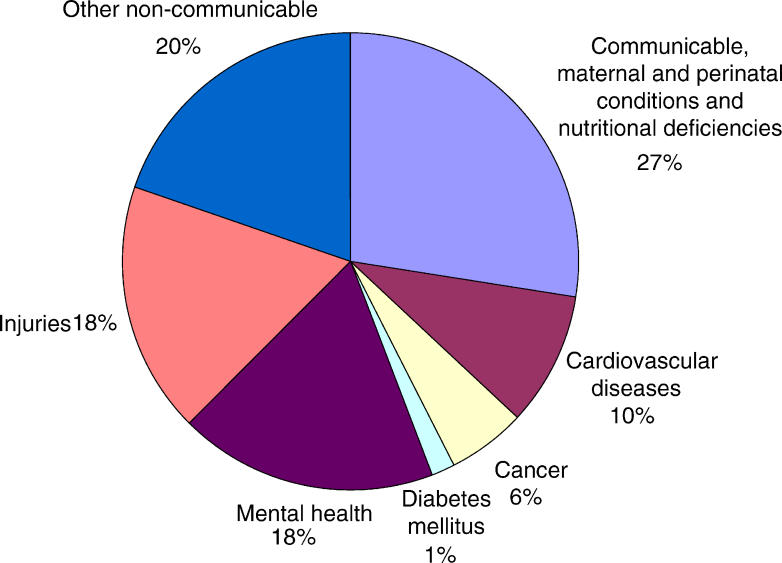
Distribution of Total DALYs (102,108,000) by Major Causes in LAC Countries in the Year 2000, Estimated by the Global Burden of Disease StudyLatin American and Caribbean countries included are listed in Figure 1.